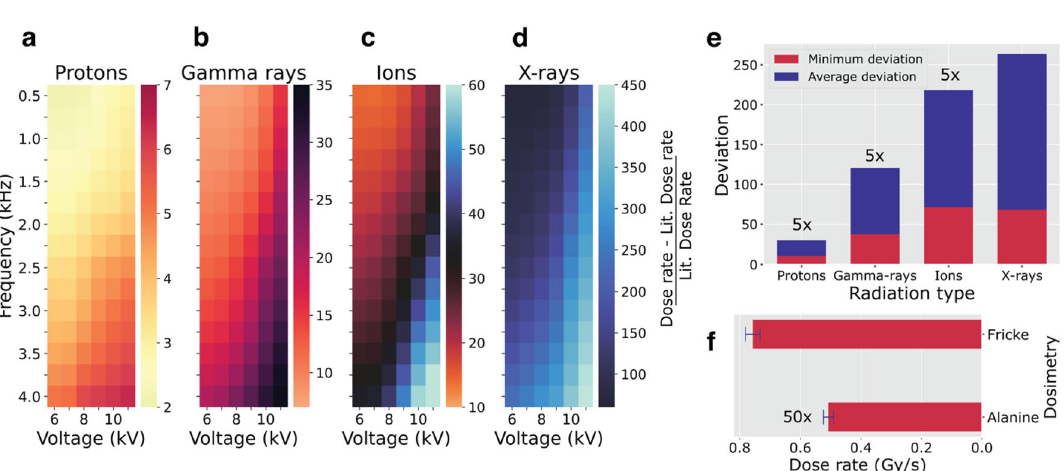
Figure 4. Comparison of LTP dose rates with dose rates for other types of radiation. Heat maps of the relative deviation of the estimated dose rate of LTP with the literature values for protons ( a ), gamma rays ( b ), ions ( c ), and X-rays ( d ) for the lowest dose-rate cluster. ( e ) Summary of the minimum relative deviation of dose rate and average relative deviation of dose rate for different radiation types. See the SI about excluding UV rays, electrons, and alpha particles in our dose-rate comparison. ( f ) The experimental results of LTP dose-rate measurements using the Fricke and alanine dosimetries irradiated at the following process parameters, 8 kV, 1 kHz, and 2 slm. See the “Methods” section and Figs. S13 and S14 for the detailed methodology and data